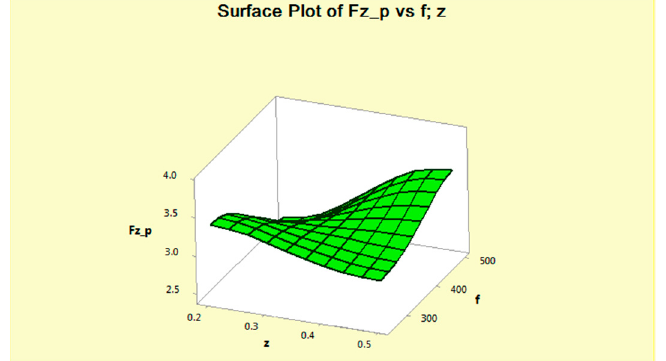
Figure 20. Surface plot of the F z-p against the feed rate and step size. Metals 2017 , 7 , 484